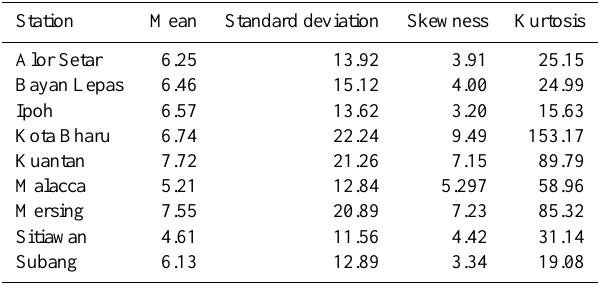
Table 2b. Statistics for the daily rainfall series before break.